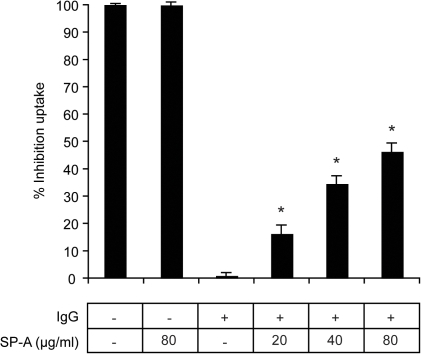
SP-A inhibits the uptake of IgG opsonized C. neoformans by alveolar macrophages.Non-IgG opsonized C. neoformans were attached/phagocytosed by less than 1% of the alveolar macrophage population in the presence or absence of SP-A, thus percent inhibition of uptake for these conditions is presented as ∼100%. SP-A (20, 40 and 80 µg/ml) significantly (P<0.001) inhibited the uptake of IgG opsonized C. neoformans (1×105) by alveolar macrophages (1×105) in a dose dependent manner (16±3.1%, 34±2.7% and 46±3.0%, respectively). Results represent the mean plus or minus the standard error of the mean of three experiments.